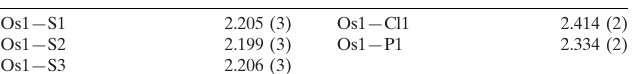
Selected bond lengths (A˚